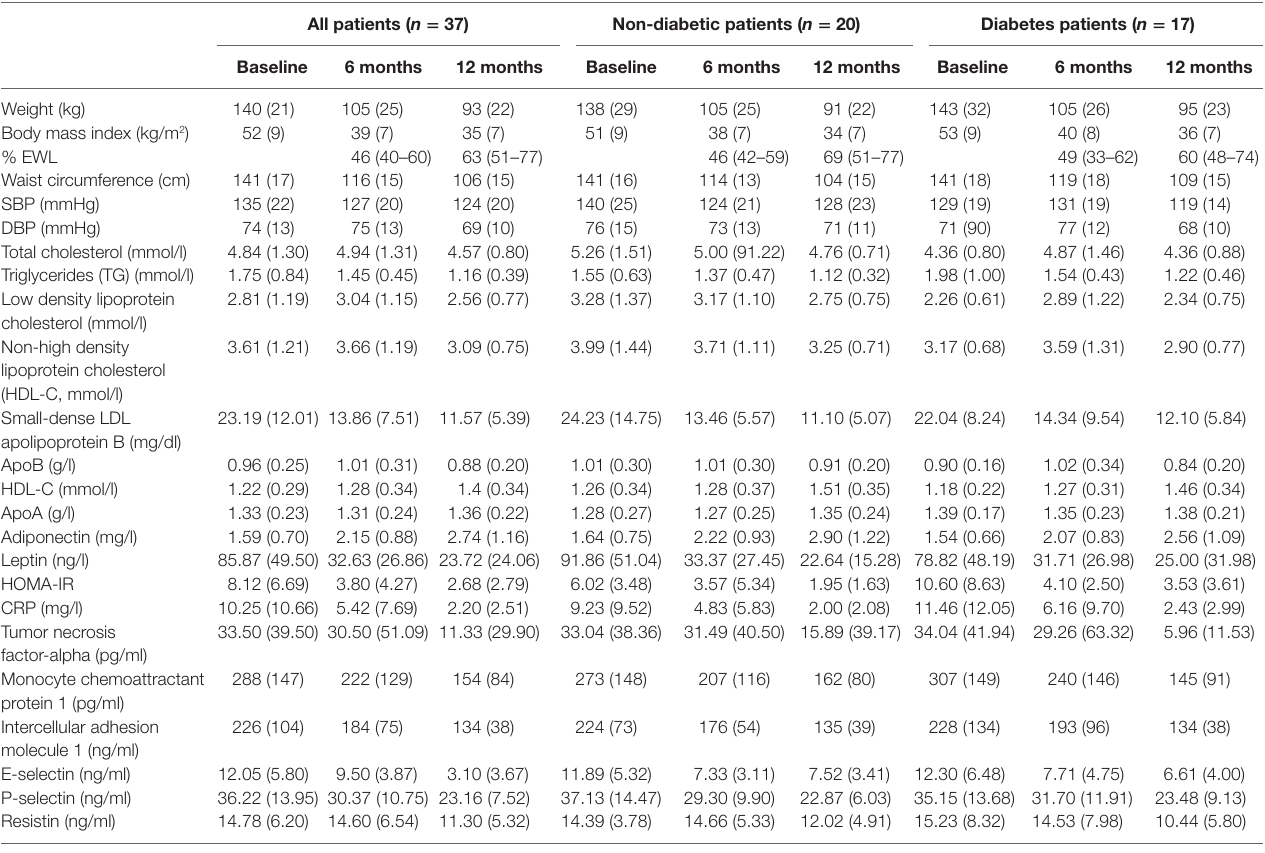
TaBle 1 | Characteristics of all patients, non-diabetic group and diabetes group at baseline, 6 months, and 12 months after surgery. all patients ( n = 37) non-diabetic patients ( n = 20) Diabetes patients ( n = 17) Baseline 6 months 12 months